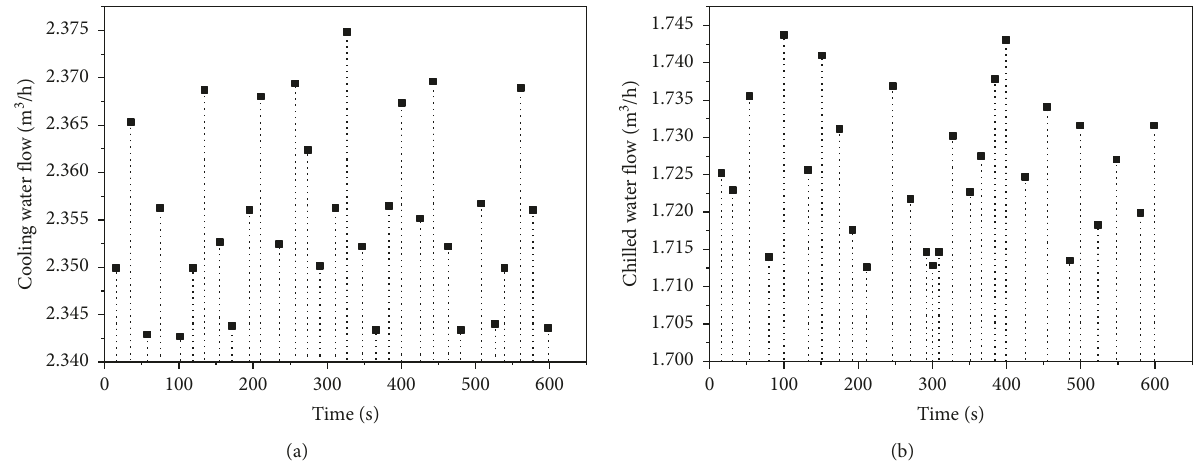
Figure 10: Stability test of water system flow. (a) Stability of cooling water flow. (b) Stability of chilled water